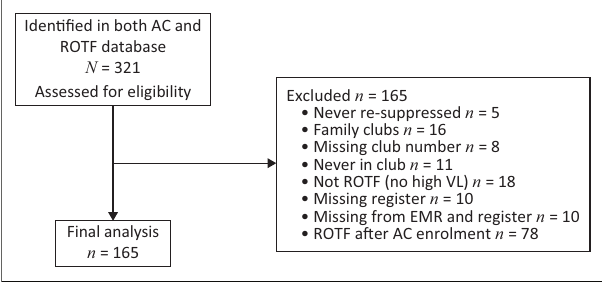
FIGURE 1: Flow chart of analysis inclusion criteria applied to obtain study sample.